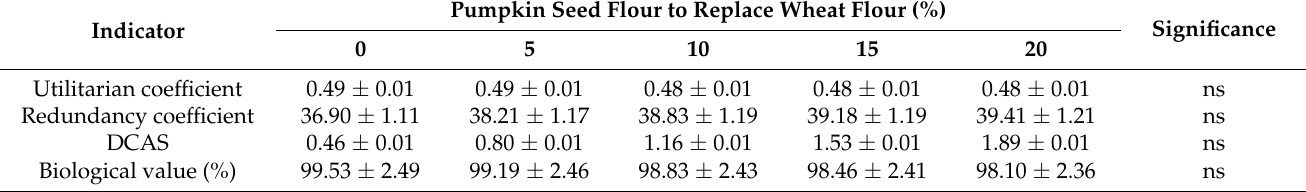
Table 5. Utilitarian coefficient, redundancy coefficient, coefficient of difference of amino acid score (DCAS), and biological value of bread with the replacement of part of wheat flour with pumpkin seed flour at different percentages (0, 5, 10, 15, and